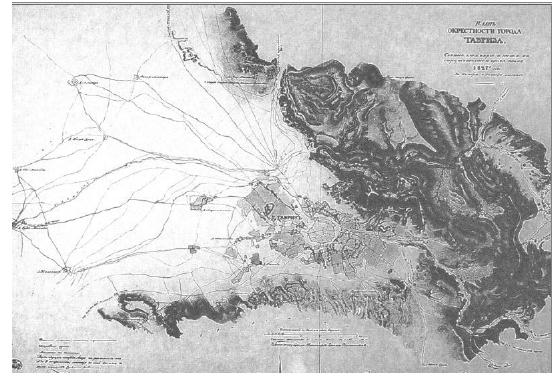
Figure 9. Map of Tabriz Drawn by Russian Engineers in Qajar Dynasty (UNESCO, 2009).